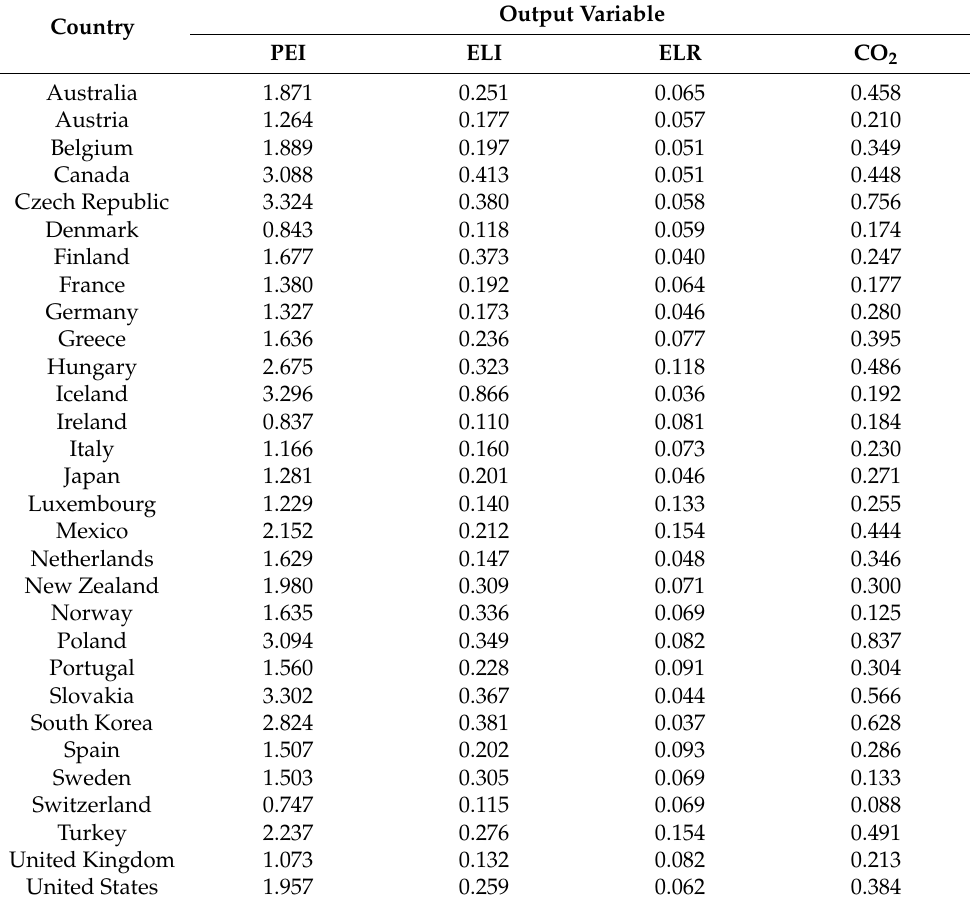
Table A4. Country means of the output variables over the entire